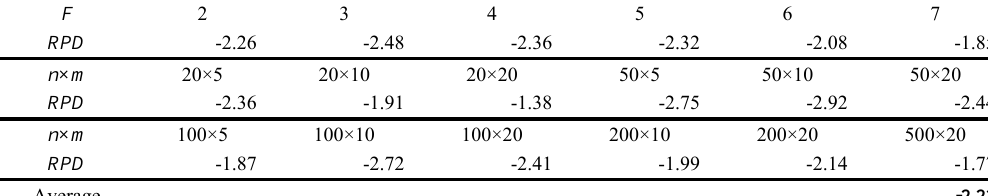
Table 1. Average relative percentage deviation ( RPD ) of